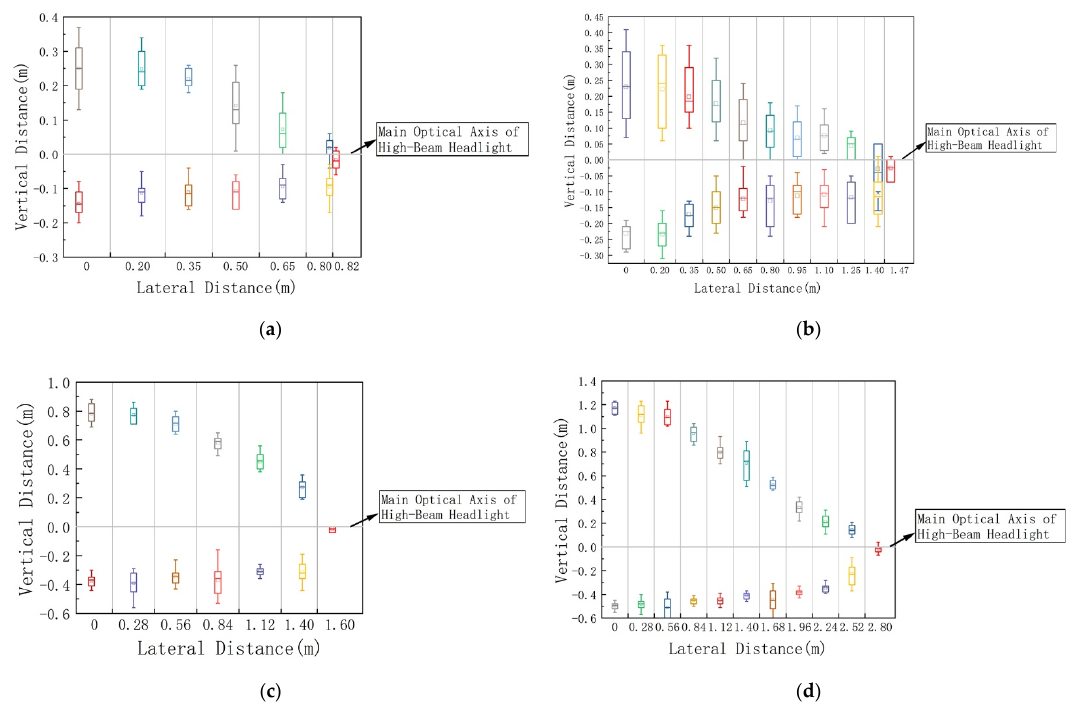
Figure 10. Statistical boxplots of vertical distance under different lateral distances: ( a ) DGIG (longitudinal distance = 3 m); ( b ) IGAG (longitudinal distance = 3 m); ( c ) DGIG (longitudinal distance = 12 m); ( d ) IGAG (longitudinal distance = 12 m). Table 4. Difference analysis results regarding age and vertical distance under different longitudinal distances.